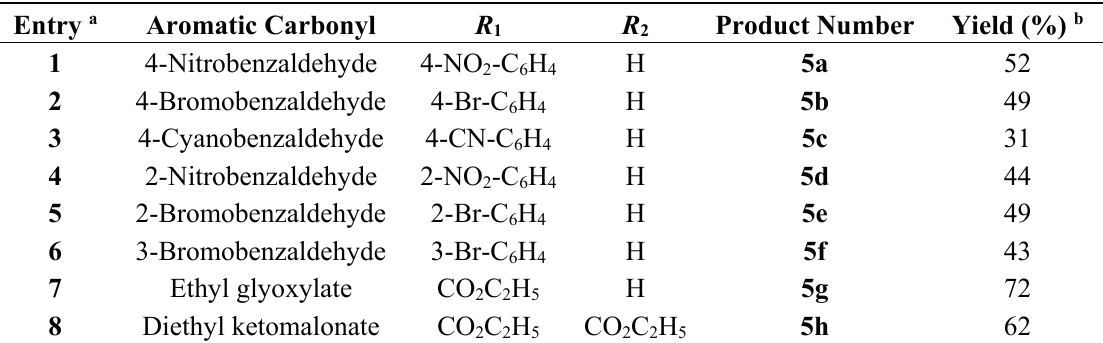
Table 1. Reaction of bromide 2 with aromatic carbonyl and α -carbonyl ester derivatives using TDAE a